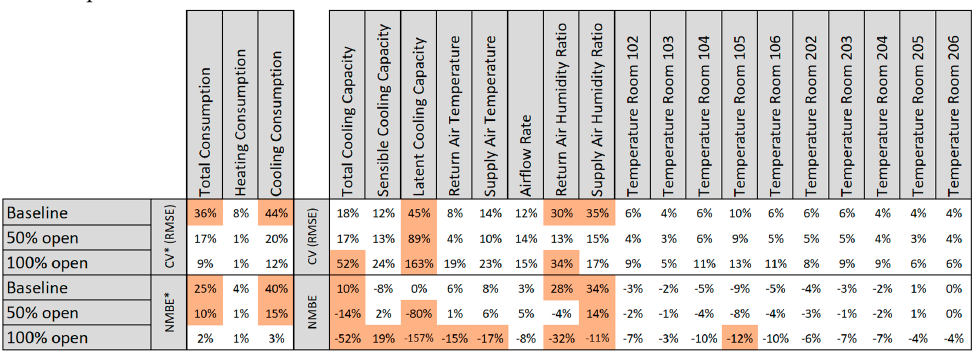
Table 11. CV (RMSE) and NMBE calculations for detailed model outputs: Economizer opening stuck at a fixed position.